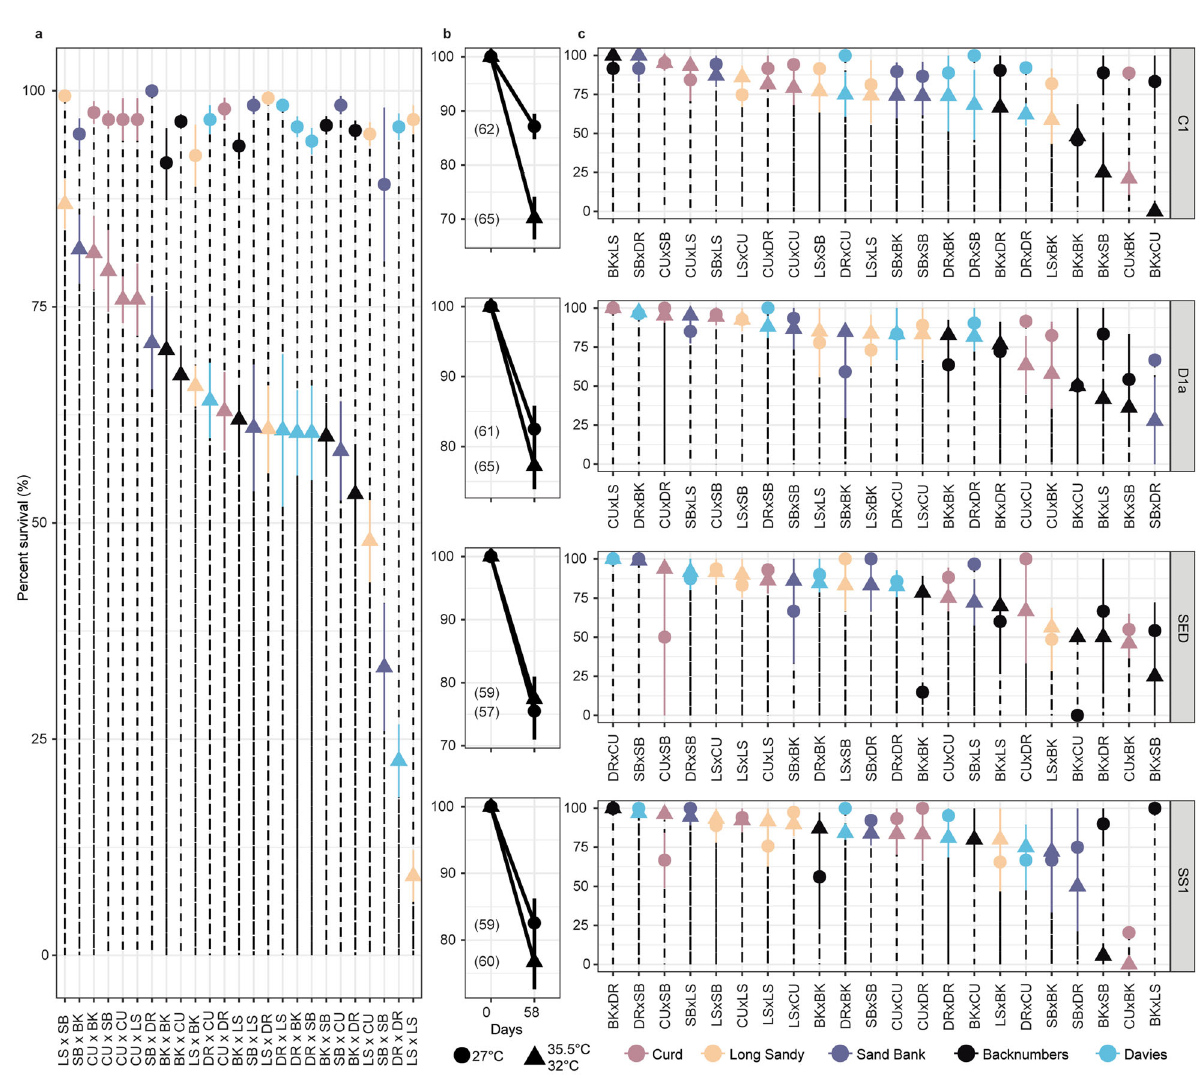
Fig. 2 Survival of purebred and hybrid coral larvae and juveniles infected with a range of symbionts and subjected to heat stress. Mean percent (%) survival ± Standard Error bars [SE] of larval ( a ) and juvenile crosses at mean (circles: 27 °C) and elevated (triangles: juveniles: 32 or larvae: 35.5 °C) temperatures across four juvenile-symbiont treatments ( b , c ). Cross labels follow the maternal coral and then paternal coral from the fi ve reef locations (Fig. 1a). For example, SBxDR describes a cross composed of eggs from Sand Bank and sperm from Davies reef. Colours correspond to where the maternal corals were sourced (Fig. 1a). Juveniles were infected with four Symbiodiniaceae treatments listed along the vertical facets ( b ), including wild-type Cladocopium goreaui W10 (C1), Durusdinium trenchii (D1a), the free-living wild-caught mixture found within the sediments collected from the warmest reef (Curd), and the heat-evolved “ selected strain ” derived from C. goreaui (SS1). The mean survival at the fi nal timepoint [±SE] for mean and elevated temperature treatments are shown for aposymbiotic larvae and for each of the four symbiont treatments averaged over all juvenile crosses at the two treatment temperatures ( b ) or separated by cross ( c ). Crosses for each symbiont treatment are ordered from the highest survival at elevated temperatures to the lowest survival at elevated temperatures. A summary of sample sizes can be found in Supplementary Table 3 and Supplementary Data 1. The asterisk in panel b denotes a signi fi cant difference between mean and elevated survival ( P = 0.001 ). Differences in survival were assessed using the non-parametric, two-sided Wilcox test and were p-adjusted for multiple pairwise tests using the “ Bonferroni ”